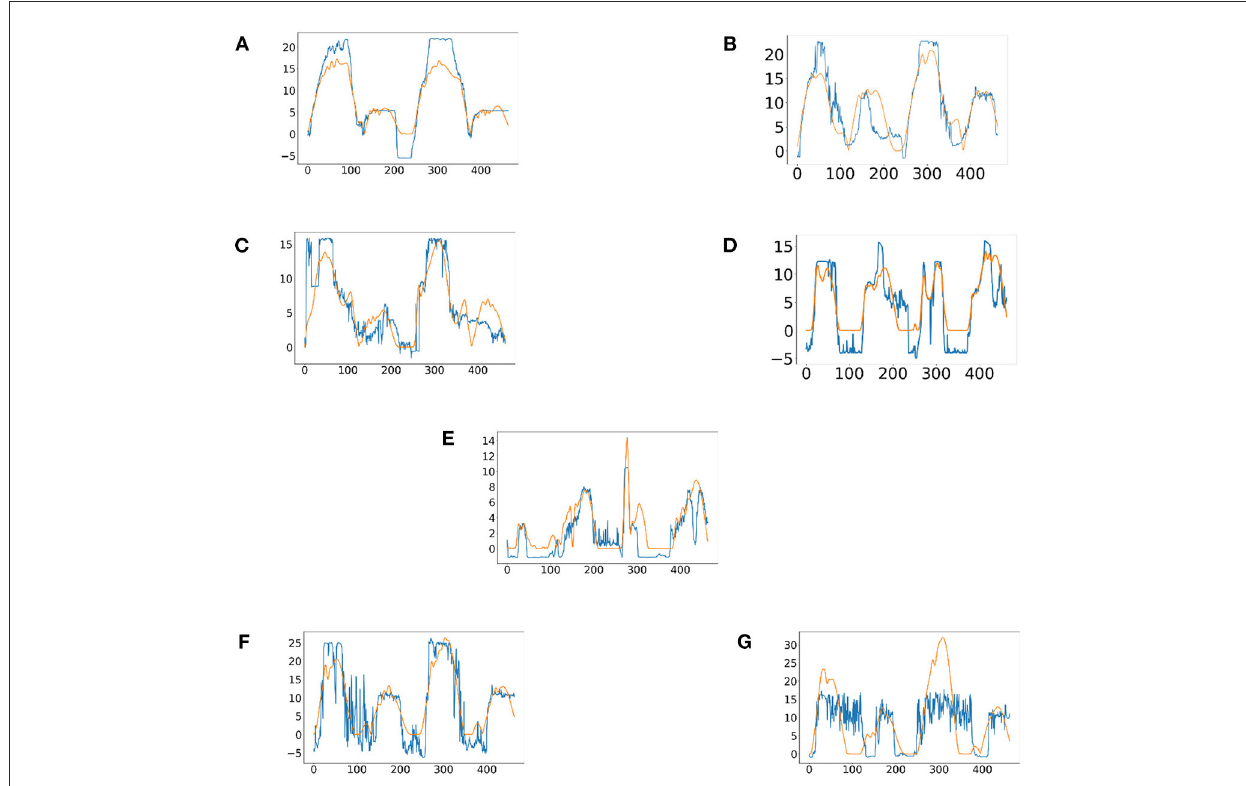
FIGURE8 The predicted results of the perceived torques of participant one in seven experimental protocols. (A) Passive training with slight motor ability (PT + ). (B) Complete passive training (PT). (C) Active training with weaker motor ability (AT-). (D) Normal active training (AT). (E) Active training with stronger motor ability (AT + ). (F) Resistive training with weaker motor ability (RT-). (G) resistive training (RT).